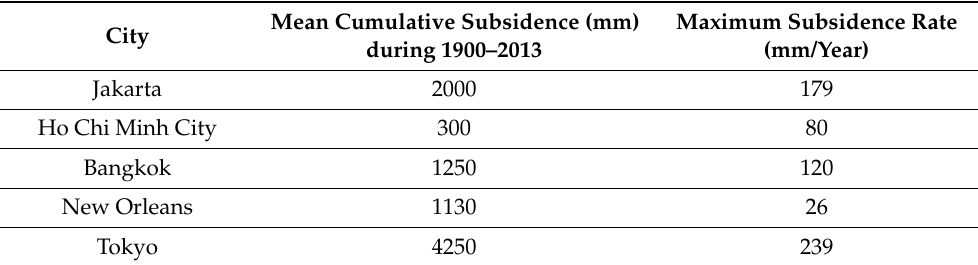
Table 2. Cumulative subsidence and maximum subsidence rate for selected cities from 1900–2013 (adapted from Erkens et al.